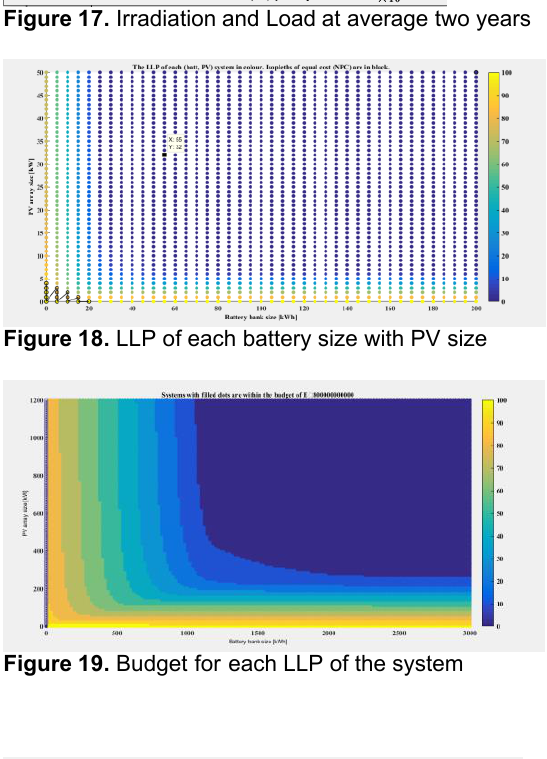
Figure 21. Isodepth of Equal Costs at 1000 to 600